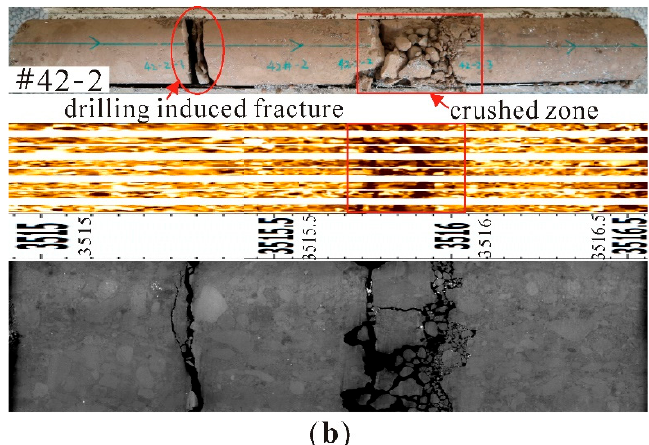
Figure 10. Conjugate shear fracture and crushed zone in a slant core. ( a ) Scissor-shaped conjugate shear fracture is straight in morphology and has through-penetrating gravel surface. ( b ) Crushed zone, which forms when shear slip occurs at the weak-cemented planes.